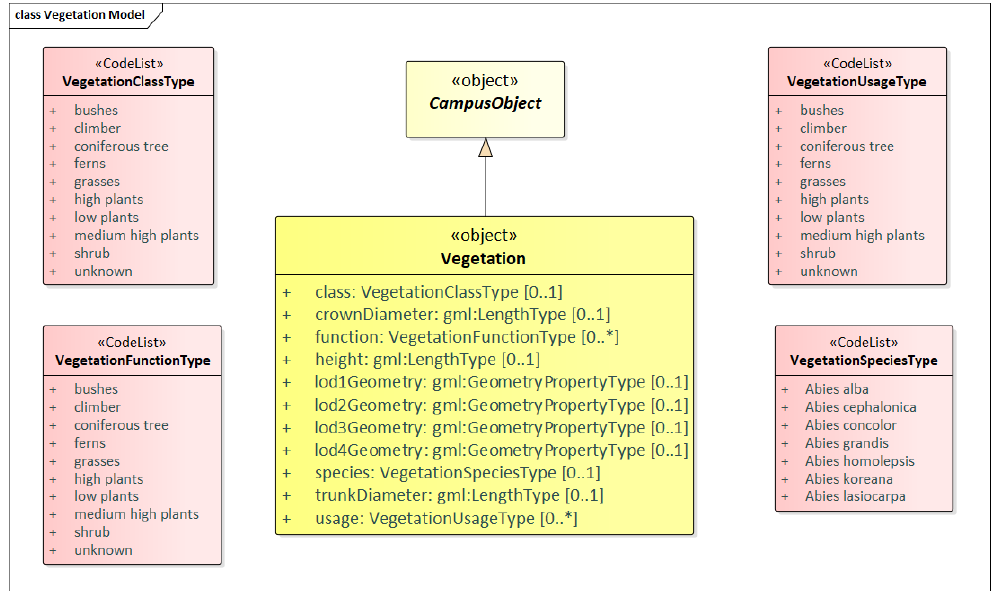
Figure 13. UML diagram of vegetation